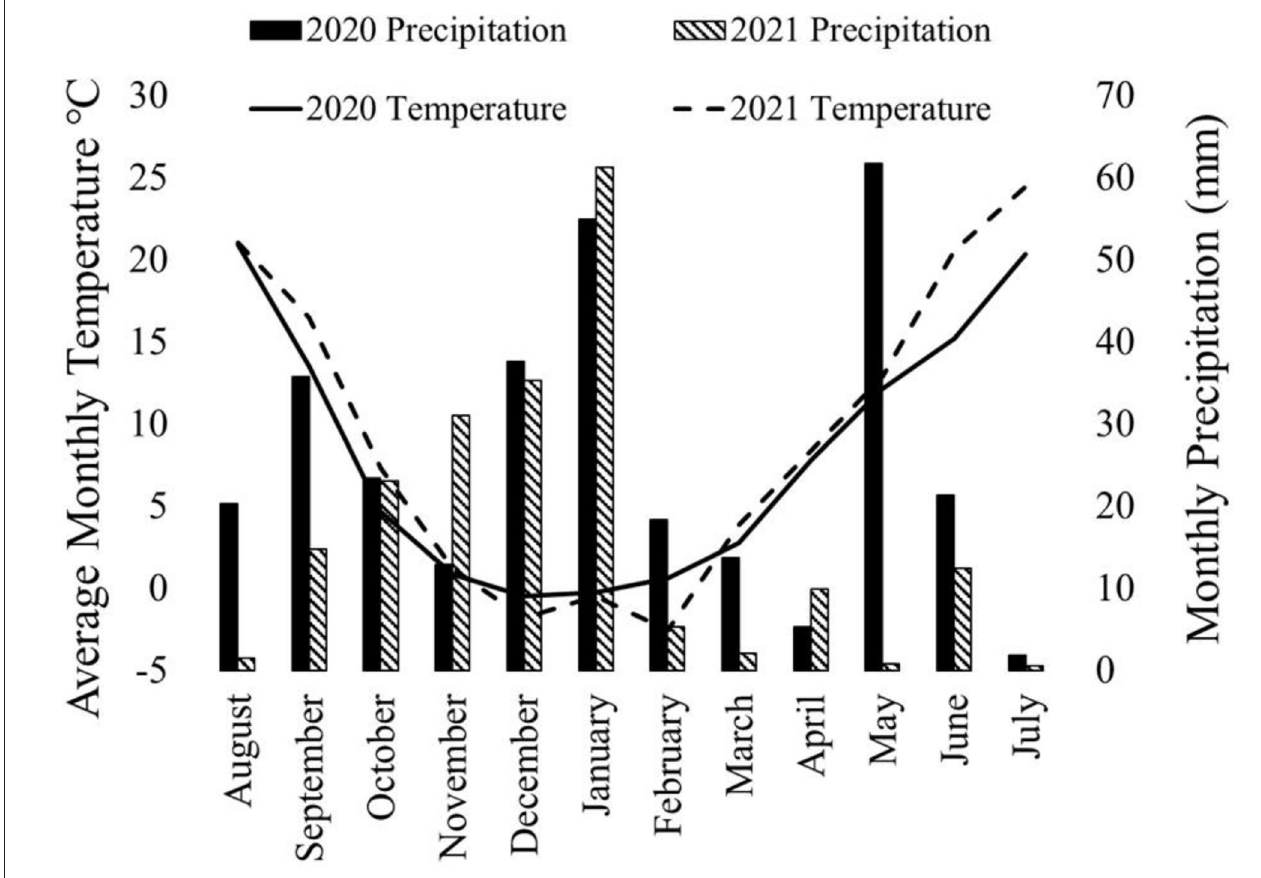
FIGURE 1 | Precipitation and temperature on a month-by-month basis for the 2019–2020 growing season and the 2020–2021 growing season. Spring (March, April, and May) precipitation was substantially higher in 2020 than 2021. Additionally, June and July average temperatures were warmer in 2021 than in 2020. This chart was developed using data from WSU AgWeatherNet (https://weather.wsu.edu/).